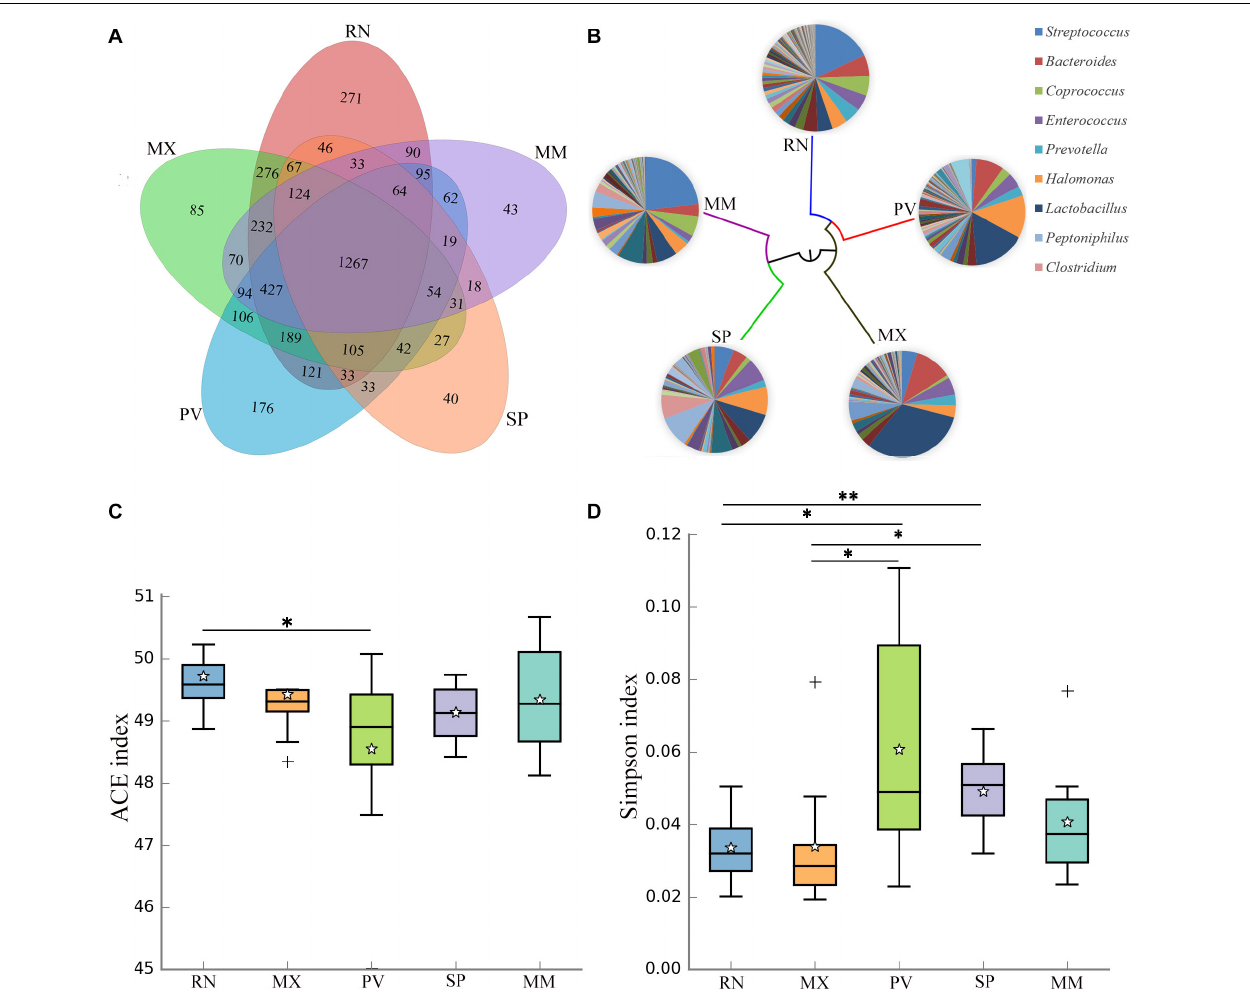
FIGURE 2 | Gut microbial communities in different pheasant lineages [ring-necked pheasant (RN), manchurian pheasant (MX), phasianus versicolor (PV), Shenhong pheasant (SP), and melanistic mutant pheasant (MM)]. (A) The Venn diagram shows the OTUs shared within different lines. (B) Aggregate microbiota composition and dendrogram at different lineages. Only major taxonomic groups are shown in pie chart. (C) Alpha diversity of ACE index in five pheasant lineages. (D) Alpha diversity of Simpson index in five pheasant lineages. ∗ p < 0.05 and ∗∗ p <